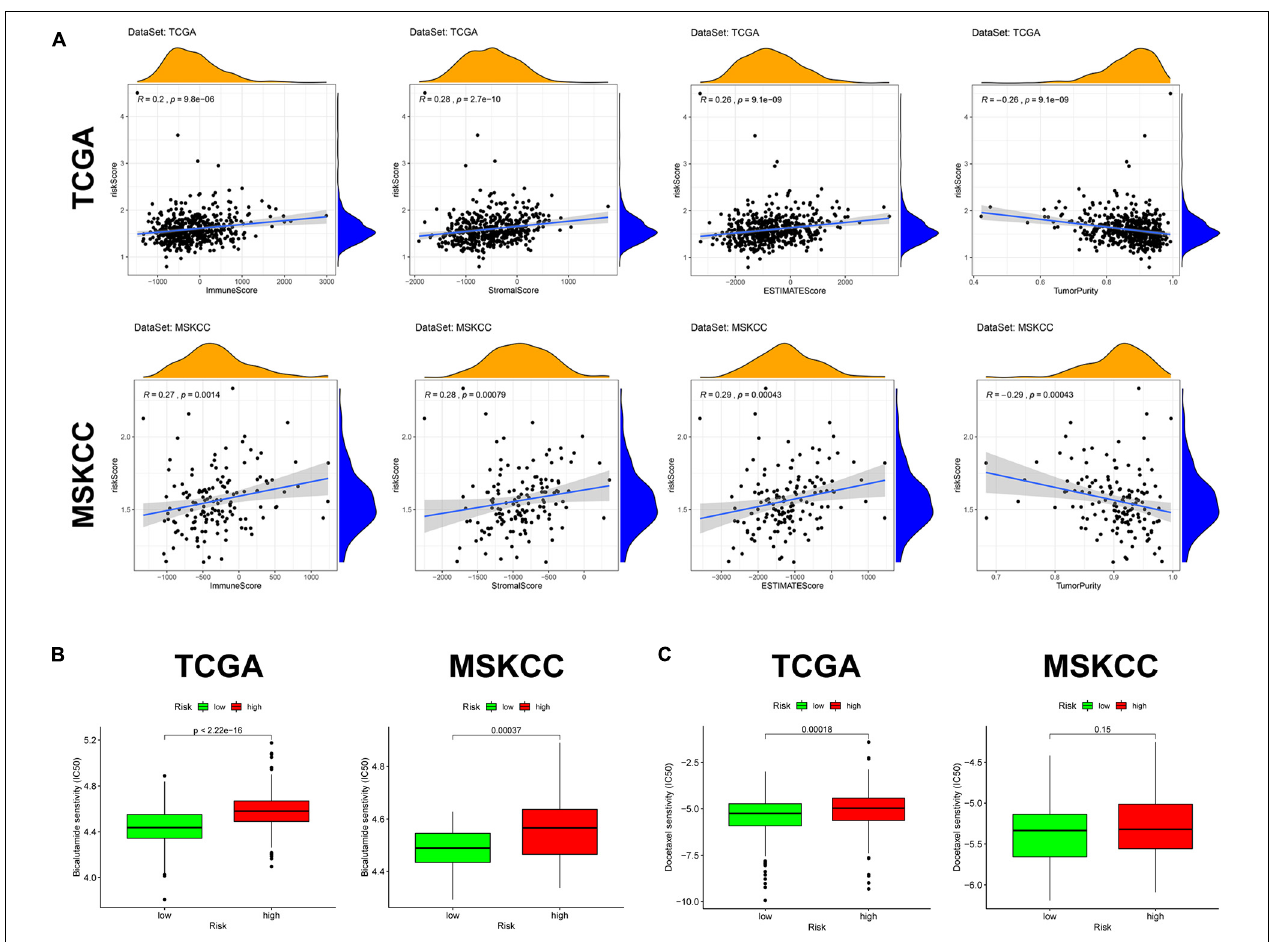
FIGURE 9 | Tumor microenvironment and prediction of therapeutic response in the two cohorts. (A) Tumor microenvironment in the two cohorts. (B) Sensitivity to bicalutamide in different risk groups. (C) Sensitivity to docetaxel in different risk